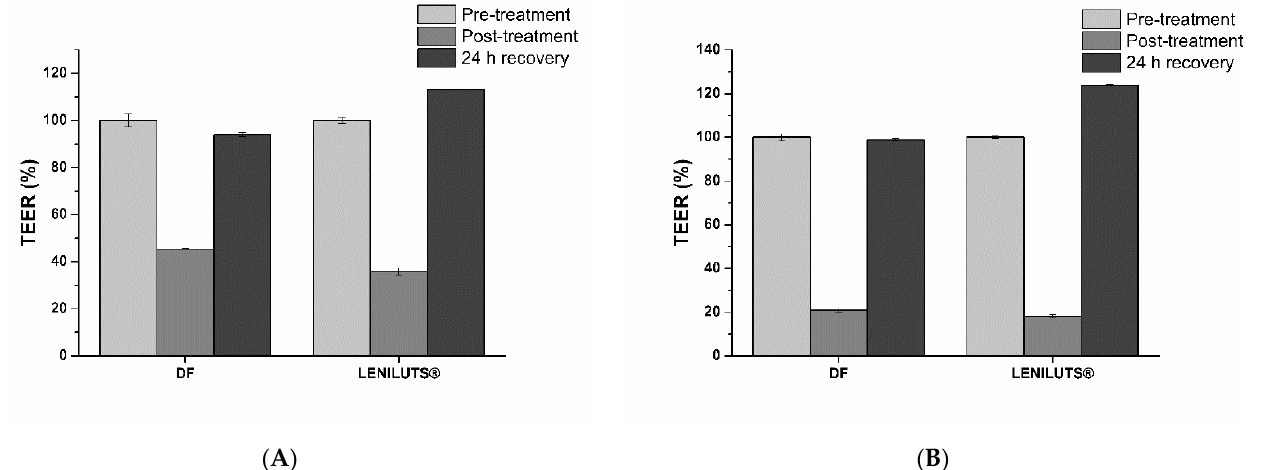
Figure 8. Trans-epithelial electrical resistance (TEER) trend following 1 ( A ) and 3 h ( B ) exposure to digested LENILUTS ® .